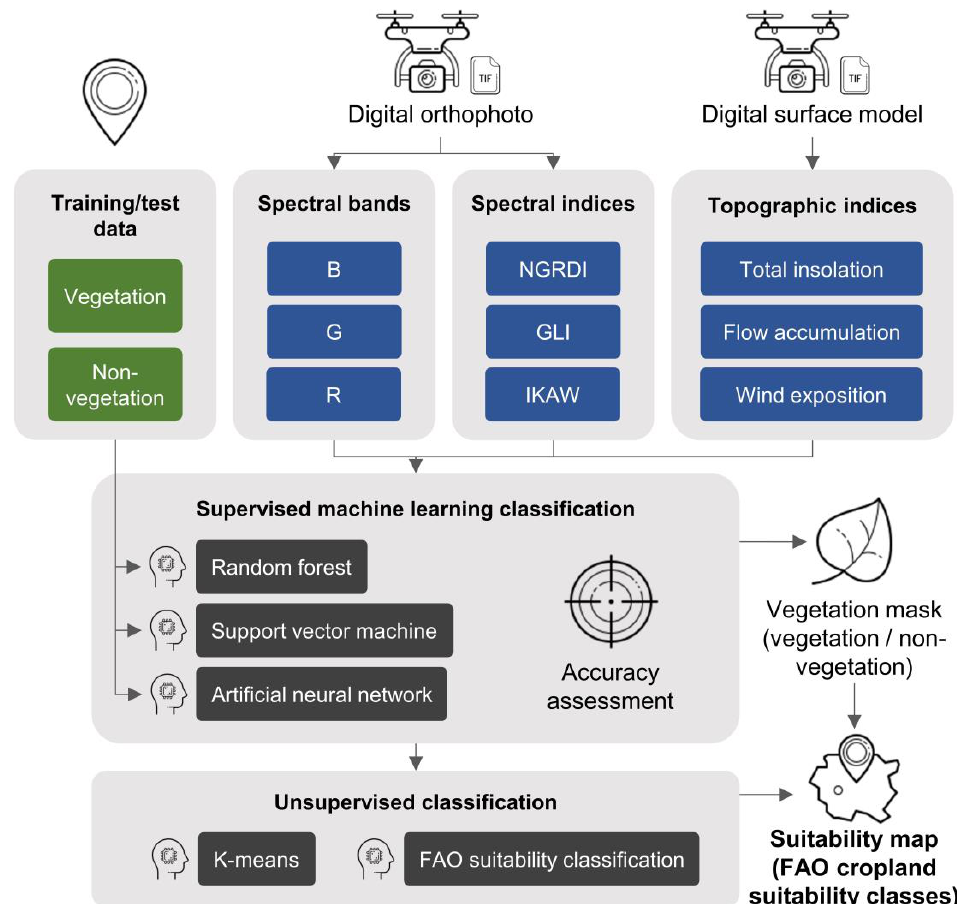
Figure 4. The proposed cropland suitability assessment method at the micro-scale. Training/test data were delineated according to the ground truth observations into two classes (vegetation and non-vegetation). The total area of training/test data was 368.5 m 2 , covering 1.9% of the study area. The division of training and test data was performed using the stratified random split to a 60/40 ratio, creating training and test data sets cov- ering the area of 221.1 m 2 (1.1% of the study area) and 147.4 m 2 (0.8% of the study area), respectively. The input data into supervised classification using machine learning was evaluated in three variants: variant 1 with three rasters (spectral bands), variant 2 with six rasters (spectral bands and indices), and variant 3 with nine rasters (spectral bands and indices, topographic indices). Three machine learning algorithms were evaluated as well according to recommendations in previous research [48], including Random Forest (RF),